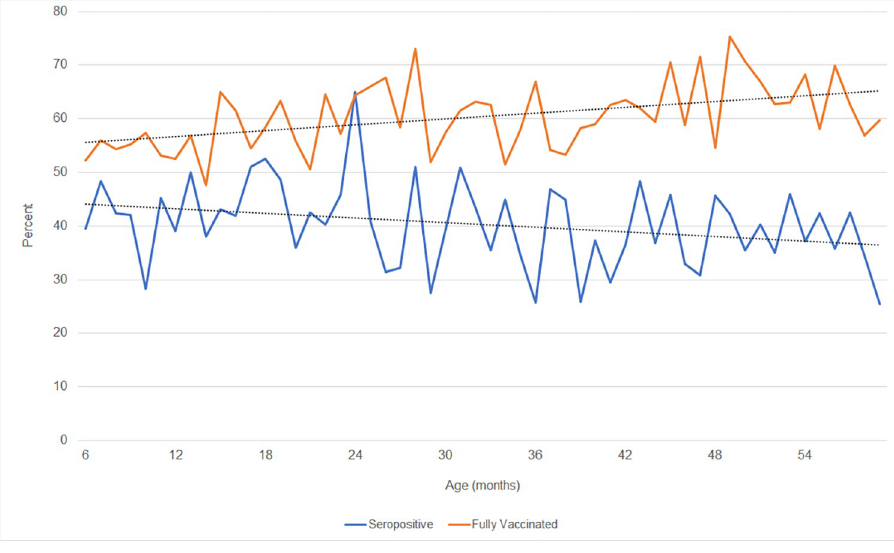
Fig 2. Tetanus seropositivity and vaccination trends by age. Tetanus seroprotection and full vaccination coverage (documentation of three doses of tetanus containing vaccine) according to age (in months) among children 6–59 months old in the EDS-RDC II (linear trend lines in